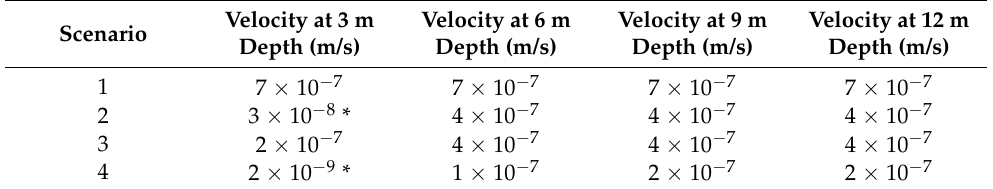
Table 3. Selected velocities for every depth according to the protocol in P-I. The symbol [*] refers to the results of limited reliability.